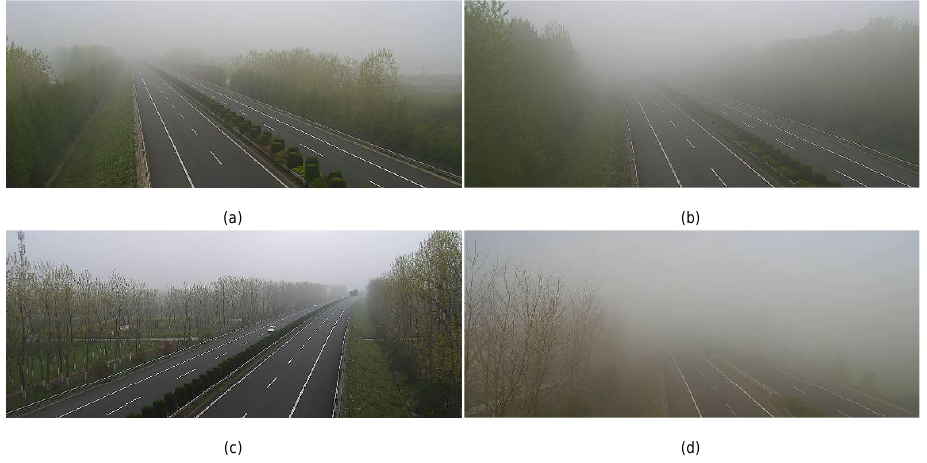
Figure 3. Foggy and hazy images (Sample images of road points 2–4, and 6 are shown in ( a – d ), respectively).